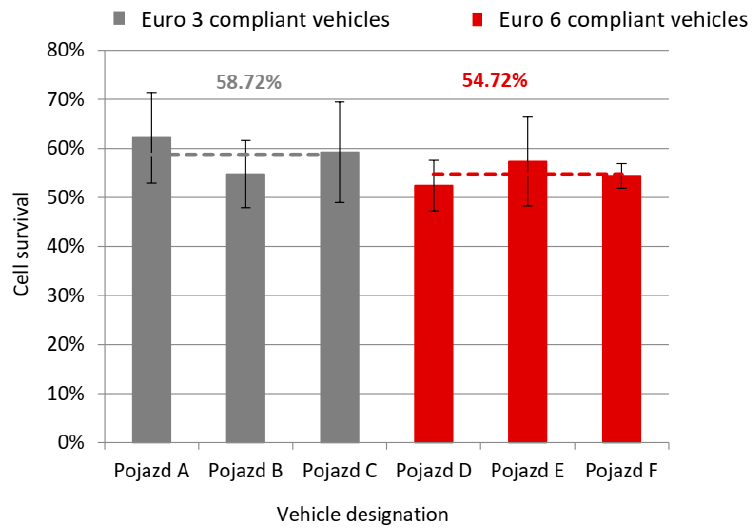
Figure 1. Mean cell survival calculated with the flow cytometry method.